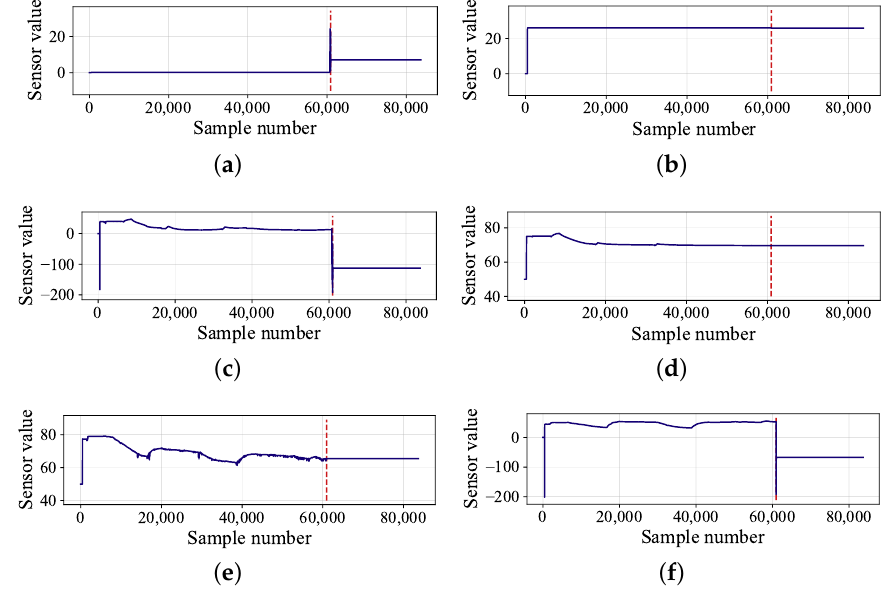
Figure 16. Depth values during the dive.